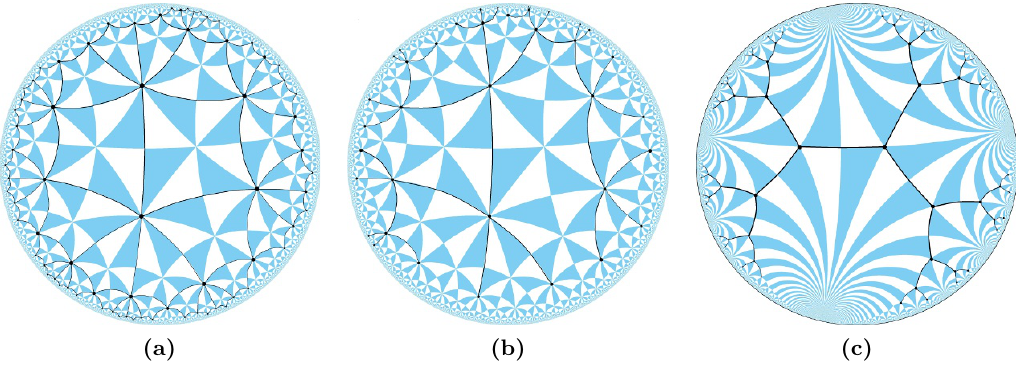
Figure 6. Tensor network embedded in a regular tessellation of Poincar(cid:19)e disk. (a): Hexagon tensor network, based on W[2 ; 4 ; 6] tilling. (b): A 4-valent tree tensor network, based on the spanning tree of W[2 ; 4 ; 6] tilling. (c): 3-valent tree tensor network, based on W[ 1 ; 2 ; 3]